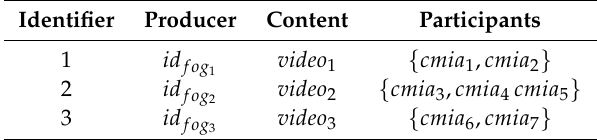
Table 2. Example of semantic knowledge assigned to multiuser